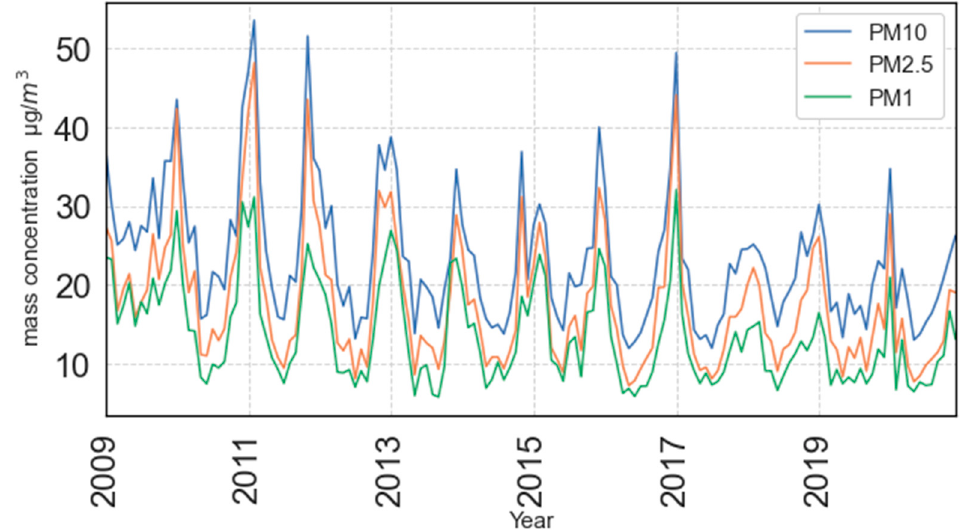
Figure 1. A time series plot of the collected particle mass concentration data from 2009–2020 for PM 1 , PM 2.5 and PM 10 . For the sake of simplicity, the data is plotted as rolling monthly averages.